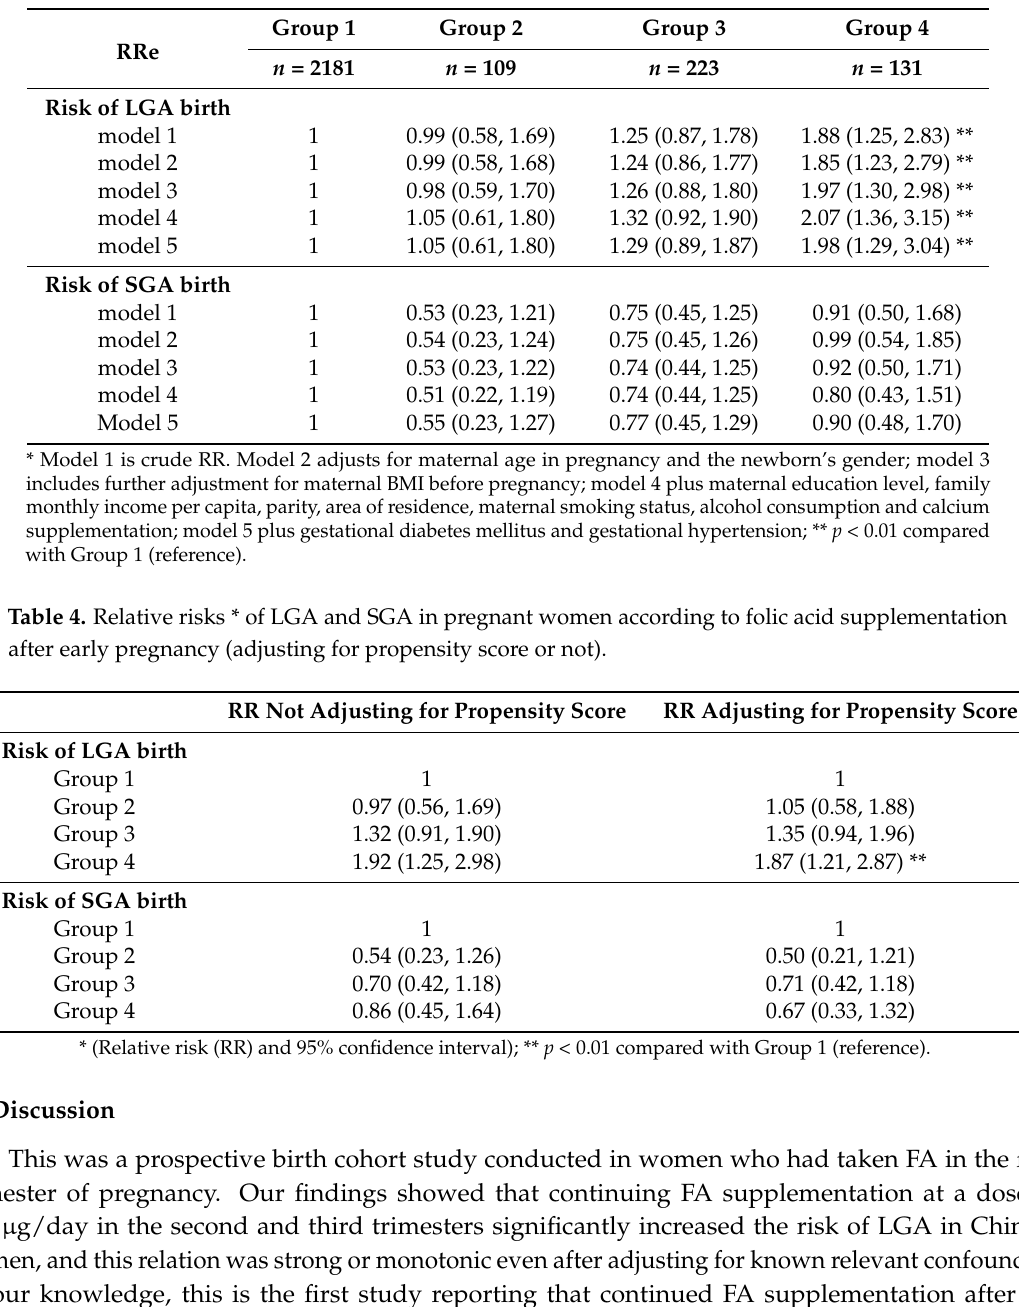
Table 3. Relative risks of LGA and SGA in pregnant women according to folic acid supplementation after early pregnancy * (relative risk (RR) and 95% confidence interval).